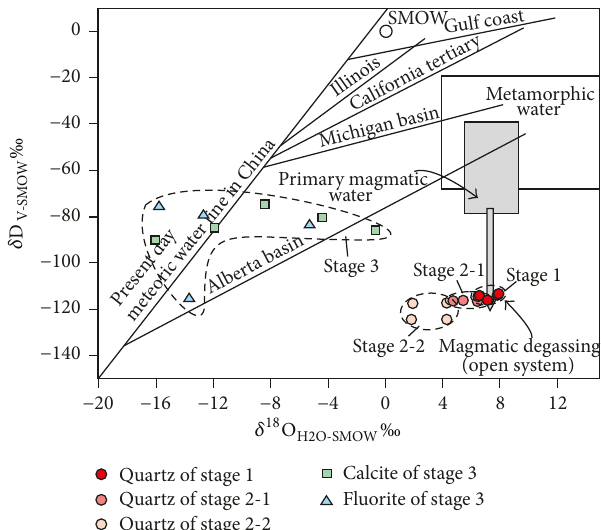
Figure 11: 𝛿 D versus 𝛿 18 O diagram for quartz, calcite, and fluorite representing different stages of mineralization at the Bairendaba Ag- Zn-Pb deposit. The data of calcite and fluorite are from Ouyang [33]. Trend lines included for reference are based on data from the Gulf Coast, Illinois, and Michigan basins [54]; Alberta Basin [55]; and California Tertiary geothermal brines [56]. Fields for metamorphic and primary magmatic waters are from Taylor Jr. [57]. Data used to derive a present-day meteoric water line for China are from Chen and Wang